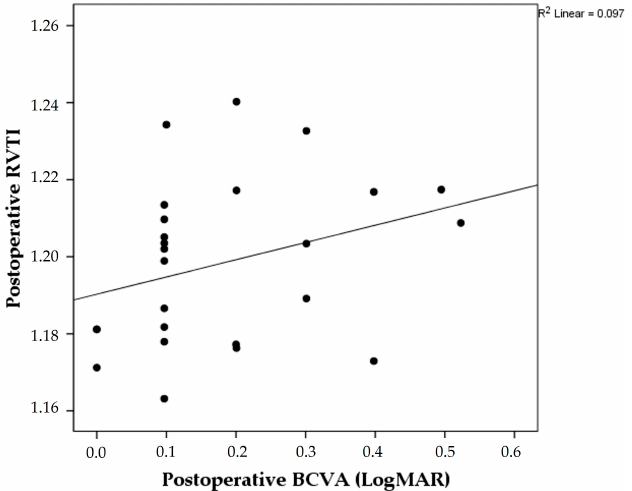
Figure 3. Scatter plot graph showing the correlation of postoperative best-corrected visual acuity (BCVA) scores and postoperative retinal vascular tortuosity index (RVTI). Table 2. Comparison of the preoperative and postoperative mean best corrected visual acuities, ret- inal vascular tortuosity indices, central subfield thicknesses, and FAZ parameters in patients accord- ing to the additional internal limiting membrane peeling.